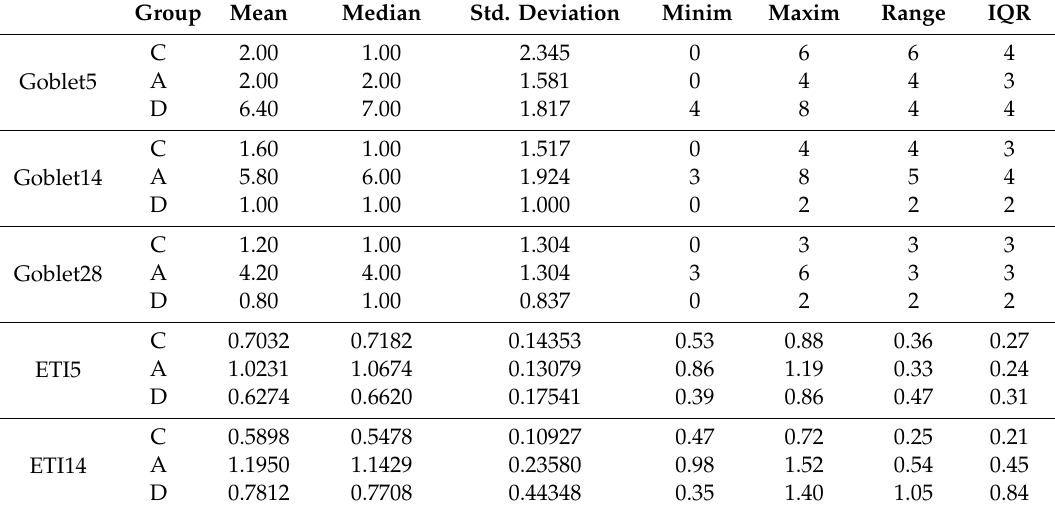
Table 1. Descriptive statistics of the variables Table 1. Kruskal–Wallis test results.